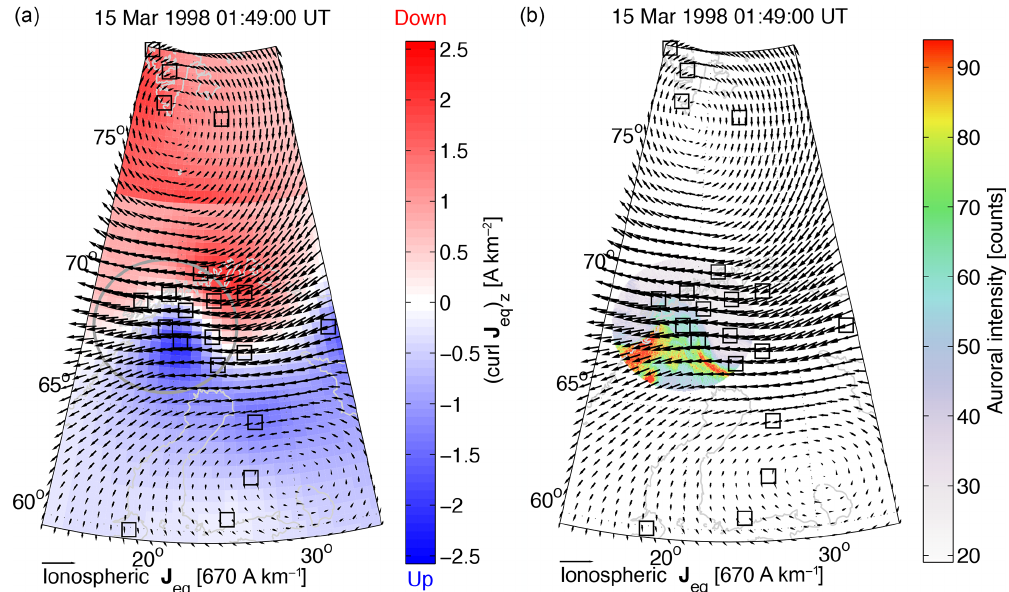
Figure 6. Distribution of equivalent currents (vectors in 670Akm − 1 ) for an omega event on 15 March 1998 at 01:49UT. The curl of the equivalent currents gives an estimate of the field-aligned current distribution (a) downward (red) and upward (blue) in Akm − 2 . An ASC image of an auroral omega structure from ABK camera has been plotted on the equivalent current vector field (b) in relative brightness units and false colour